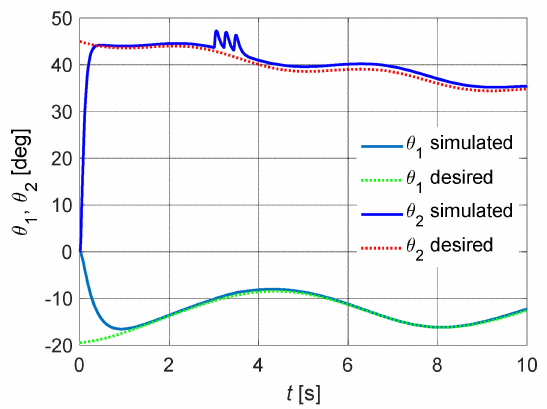
Figure 7. Angular displacements simulated and desired in azimuth and elevation with interference— PID